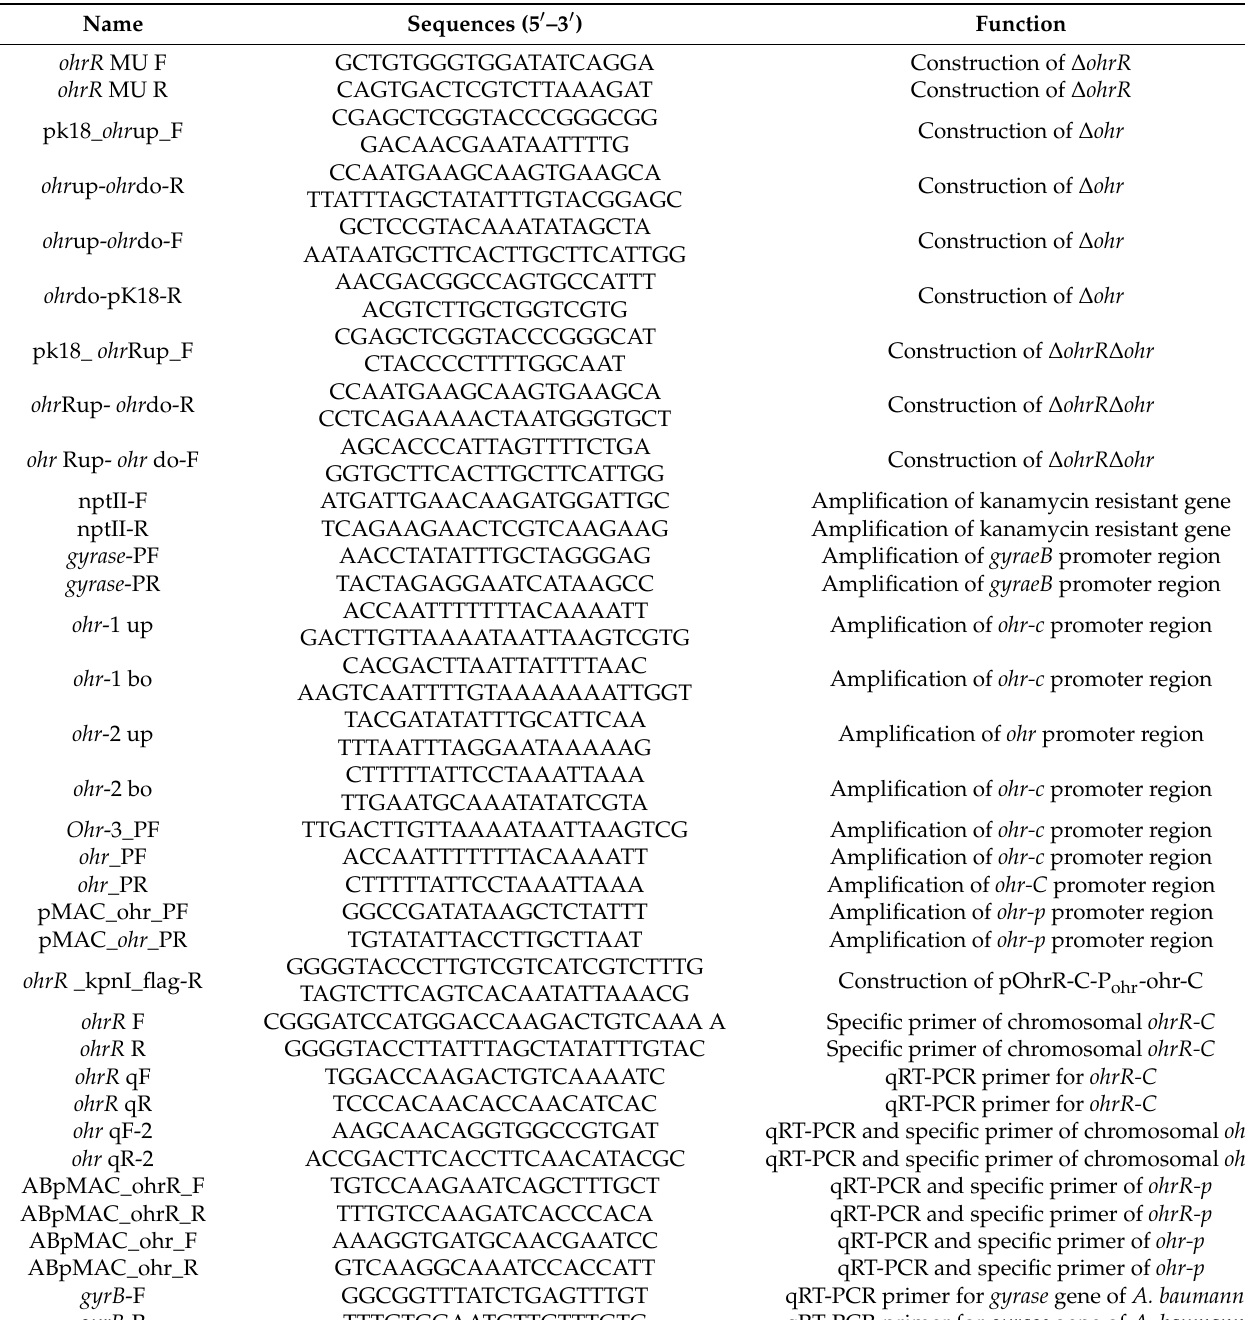
Table 2. Gene-specific primers used in this